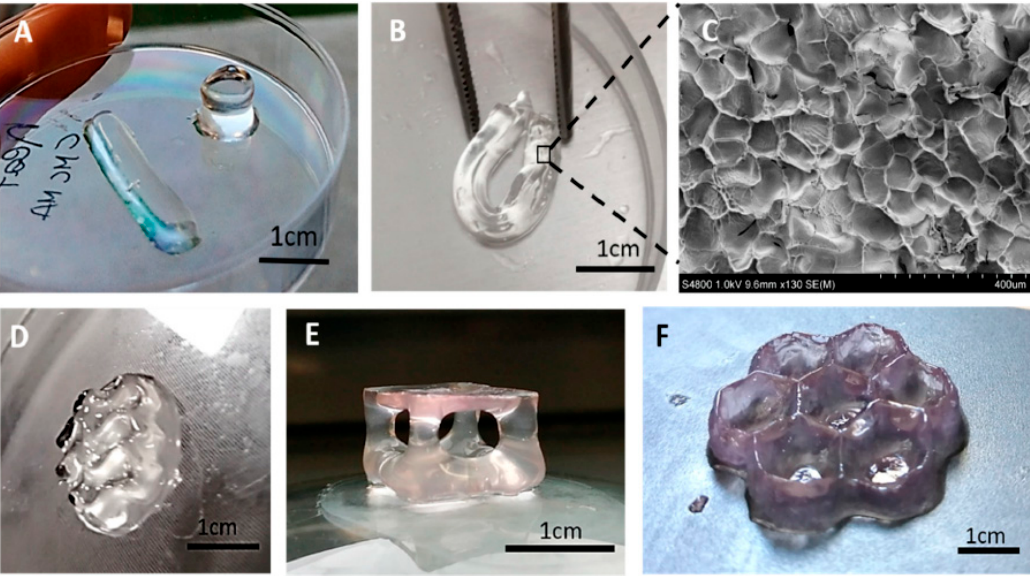
Figure 5. 3D-printed M-CMC hydrogels: ( A ) Simple cylinders and parallelepipeds (solvent: water); ( B ) The hydrogel exhibited good flexibility and handleability; ( C ) SEM analysis performed on the freeze-dried hydrogel; and 3D objects printed from water ( D ) and culture medium solution ( E,F ) [109].